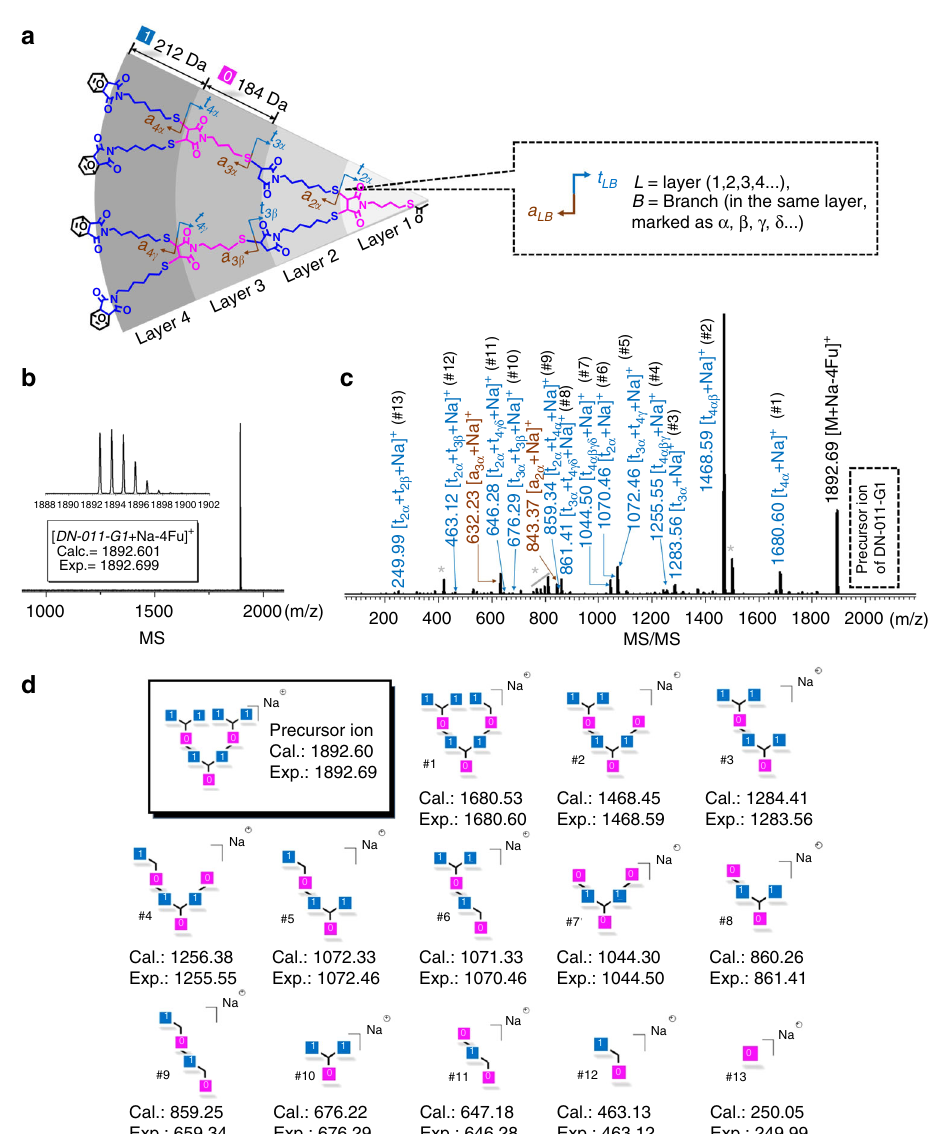
Fig. 3 MS/MS decoding digital dendrimer DN-011-G1. a Illustration of the theoretical fragmentations. b MALDI-TOF MS spectrum. c MALDI-TOF MS/MS spectrum. *Signals come from secondary fragmentations. d All the main fragments were marked from #1 to #13. Source data are provided as a Source Data fi